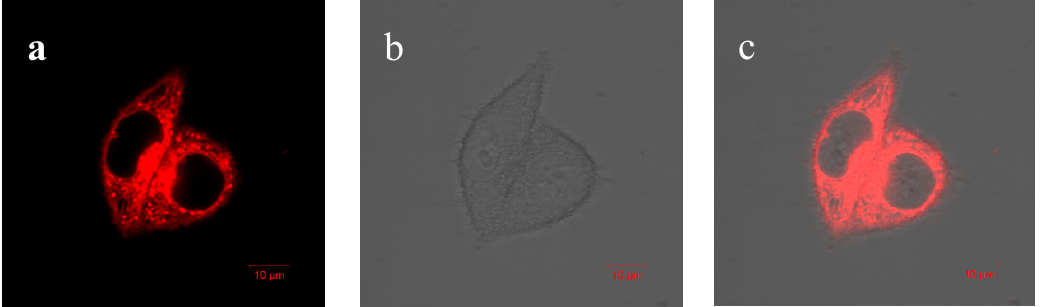
Figure 8. Confocal microscopy images of HeLa cells incubated with AIE–Fe nanodots (10 ppm) for 1 h: ( a ) in the red channel, ( b ) in the bright field, ( c ) merged image of ( a ) and ( b ). Scale bar:10 µ m.